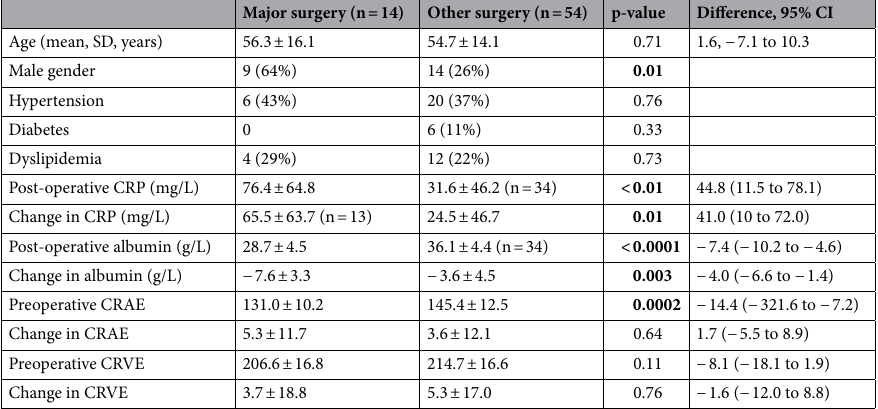
Major surgery (n = 14) Other surgery (n = 54) p-value Difference, 95%